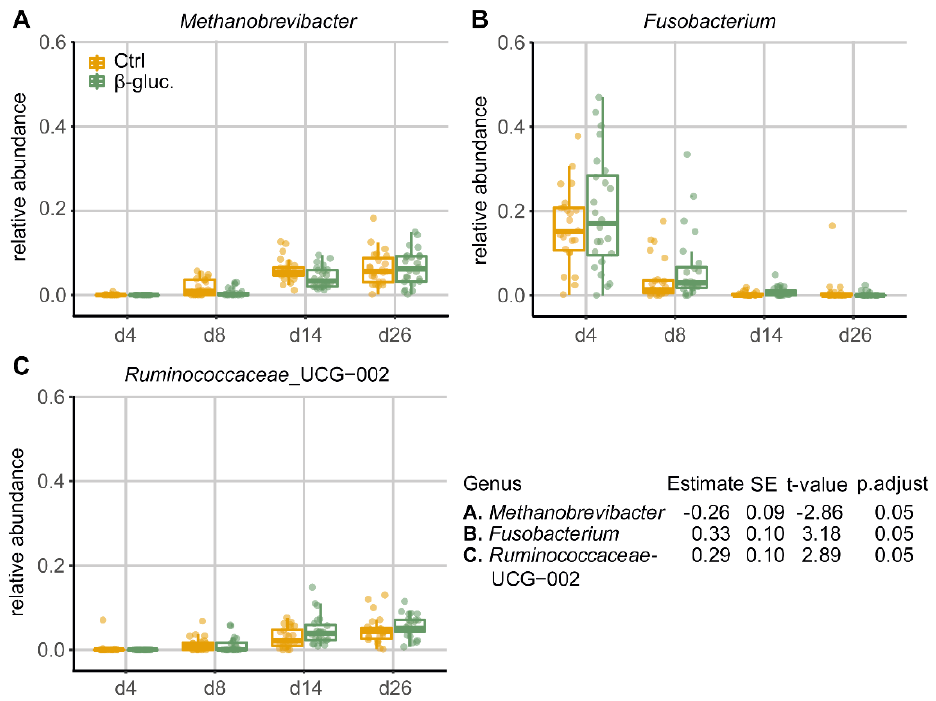
Figure 5. Relative abundances (by fraction) of differentially abundant genera in faeces during the pre-weaning period (d4-26). Shown genera resulted from comparing β-glucan animals to control animals using a GAMLSS model. Dietary intervention was used as the main variable for comparison and day of study and department were used as adjusting variables. Ear tag was used as an identifier and “fdr” was chosen as the method for multiple testing adjustment ( p .adjust < 0.05).